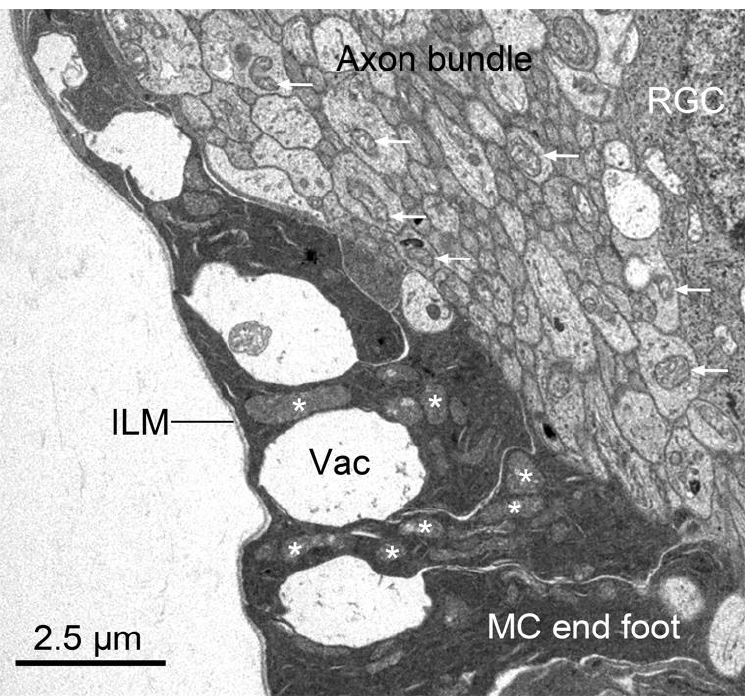
Figure 2. Müller cell end feet surround axon bundles in the nerve fiber layer. Transmission electron micrograph of a region of the nerve fiber layer of the mouse retina. In this image, the axons are sectioned transversely, appearing round. They are easily identified by the multiple microtubules arranged throughout the axoplasm. Examples of mitochondria within axons are highlighted with arrows. Müller cells (MC) extend electron-dense processes (end feet) all the way to the inner limiting membrane (ILM) and there are often large vacuole-like structures (Vac) that probably form between separate end feet, although this may be a fixation artifact. Examples of mitochondria, which are densely packed into each end foot, are highlighted with asterisks. An adjacent retinal ganglion cell (RGC) is present in the top right corner of the image.